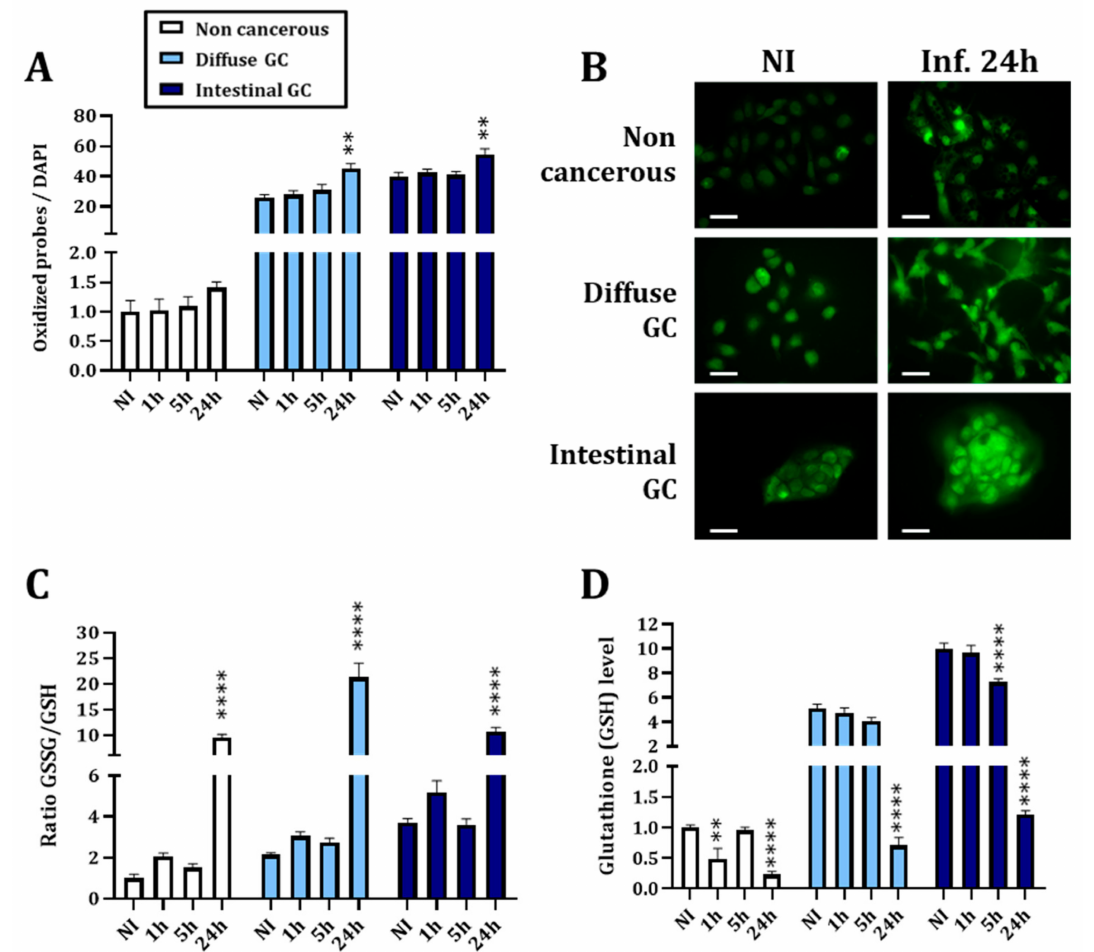
Figure 2. Infection with H. pylori increases oxidative stress and decreases the cellular glutathione level 24 h after infection. ( A ) Evaluation of ROS formation by assessing fluorescent probe signals normalized by the DAPI and read on a microplate reader in a 96-well plate. ( B ) The increase